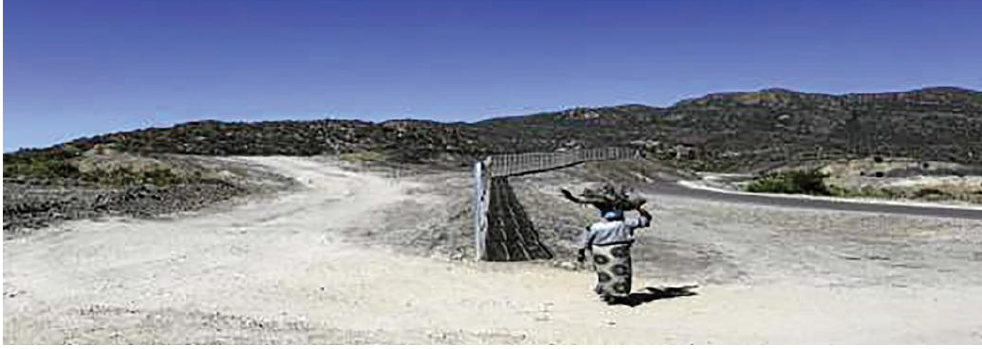
Figure 2: Screenshot of Ga-Mphahlane Village; Picture: Alaister